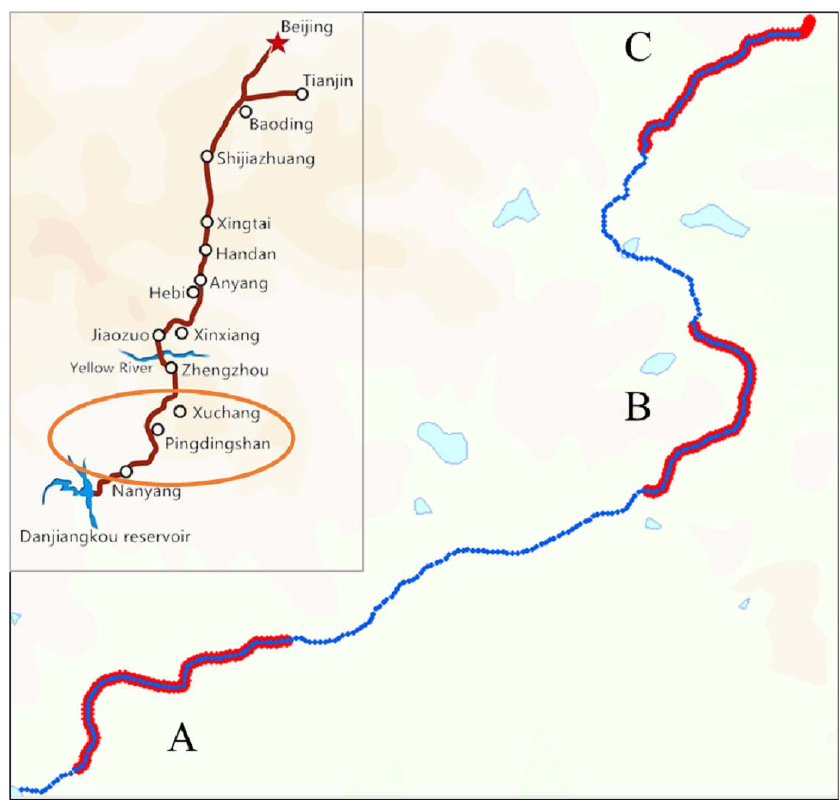
Figure 4. Modeling scope.